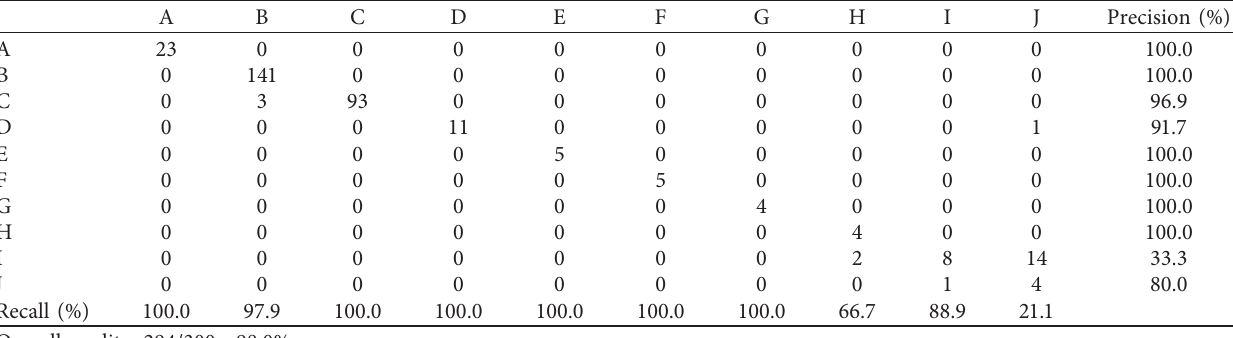
Table 6: Confusion matrix of PLO classification at Site